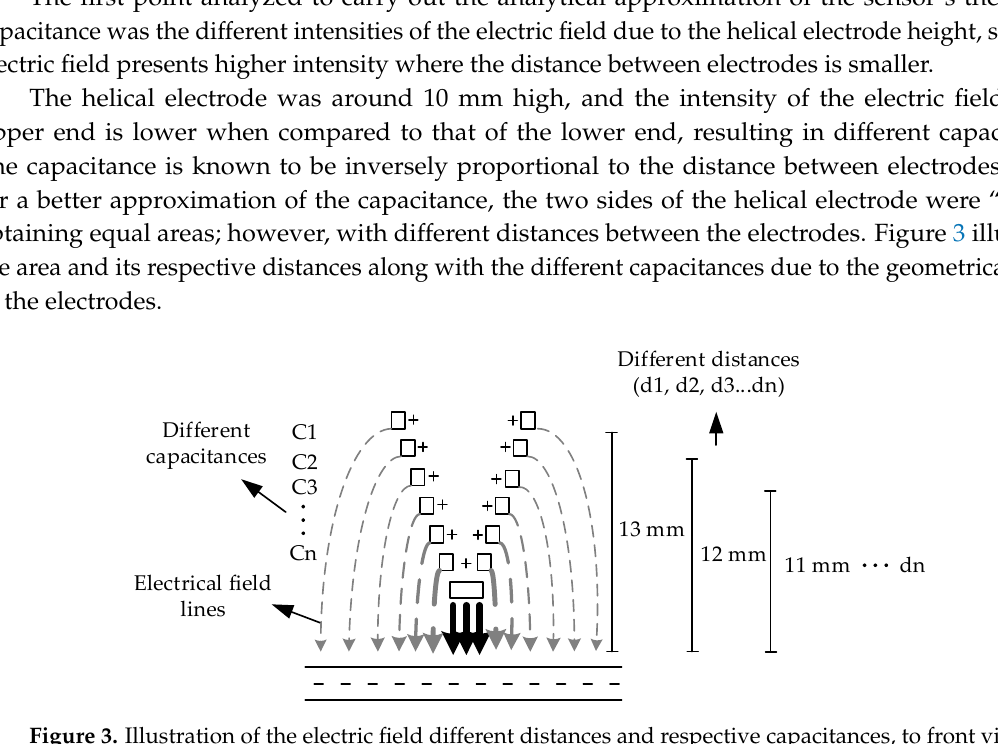
Figure 3. Illustration of the electric field different distances and respective capacitances, to front view of the flattened helical electrode.